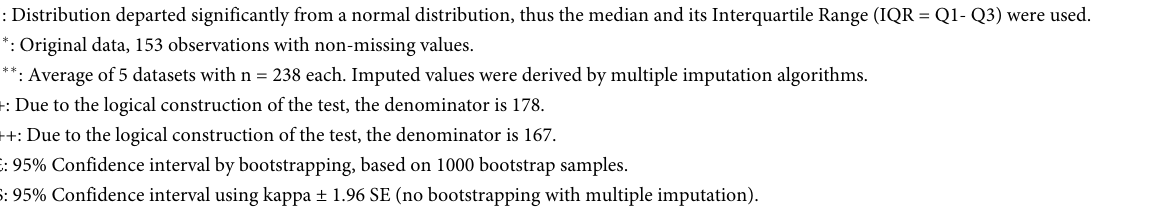
Patients’ characteristics by gender and CKD stage subgroups Distribution of the patients’ characteristics by gender and CKD stage is summarized in Table 2. Of notice, mean hemoglobin level was comparable among women and men and in the different CKD stages. However, after adjusting for CKD stage (Table 3), female gender was sig- nificantly associated with hemoglobin level < 11 g/dL (Mantel-Haenzel adjusted OR 2.54 (95%CI 1.33–5.21)). Median ferritin levels, while decreasing with CKD stage in men, had the reverse pattern in women. After adjusting for CKD stage, ferritin levels < 100 ng/ml and < 500 ng/ml were not asso- ciated with female gender (respective Mantel-Haenzel adjusted OR 1.20 (95%CI .65–2.28) and 1.10 (95%CI.46 – 2.29)), although interaction cannot be completely excluded (p interaction = .081). As compared to women in CKD stage 3, median TSAT was higher in men, while the pattern was reversed in CKD stage 4. The gender by CKD stage interaction was significant for TSAT < 20% and TSAT < 30%, and thus precluded deriving a usable Mantel-Haenzel adjusted OR.